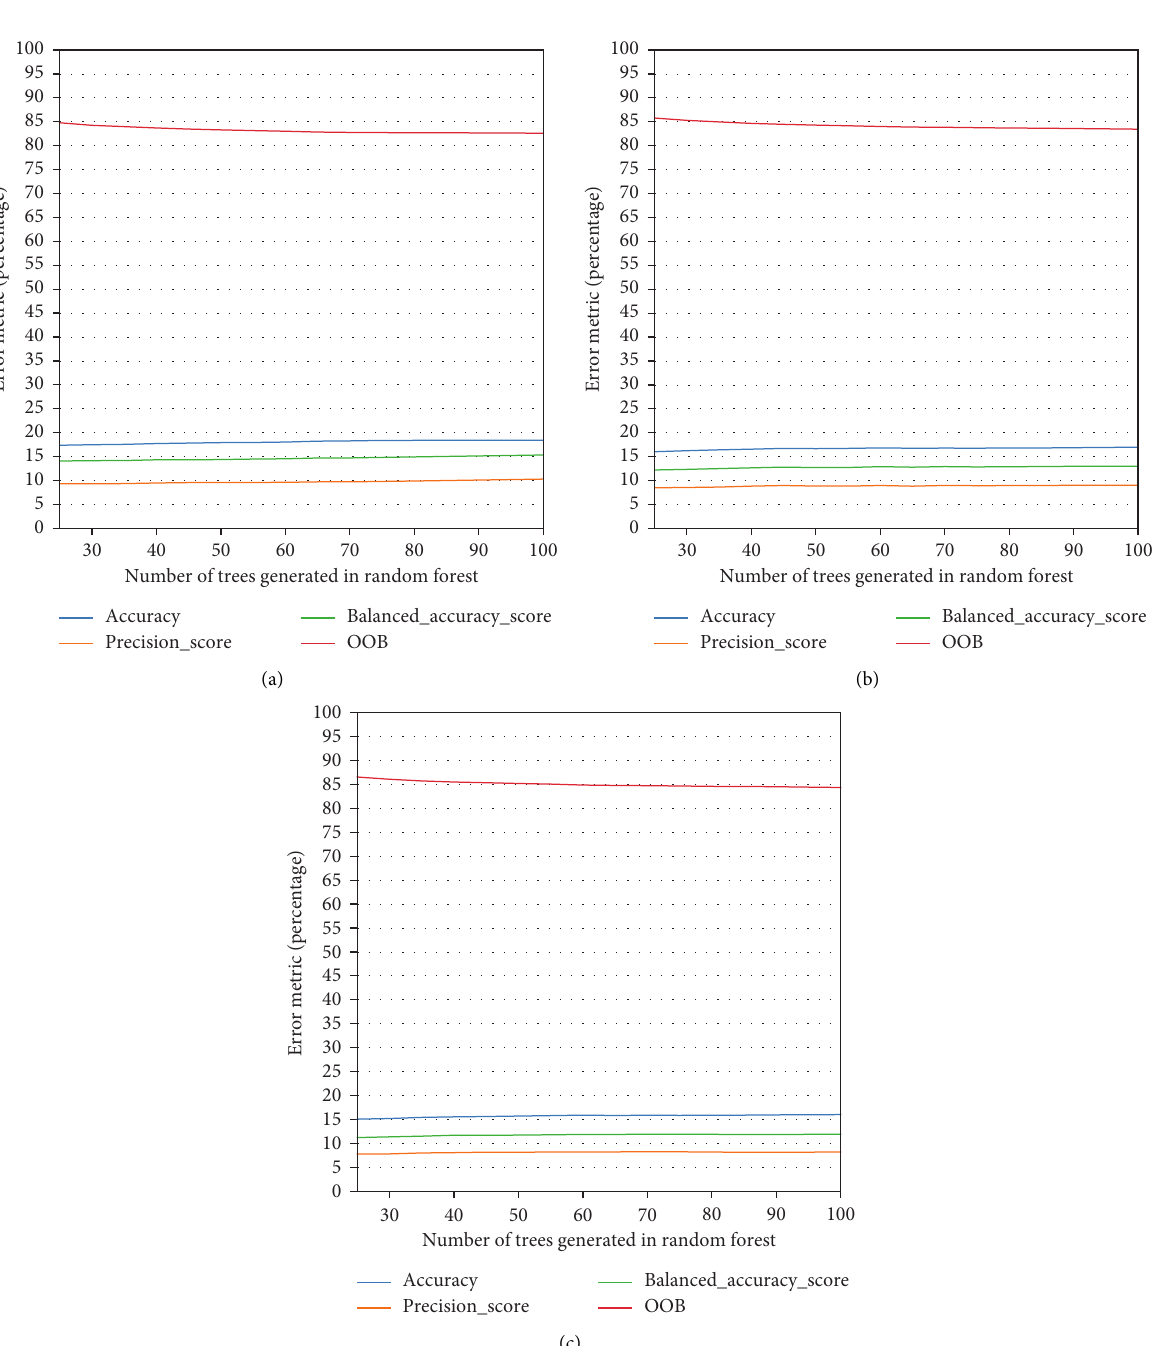
Figure 6: Relationship between trees in random forests and error metrics (accuracy, precision, balanced accuracy, and OOB) for different ratios of training and testing subsets. (a) 90:10. (b) 80: 20. (c)